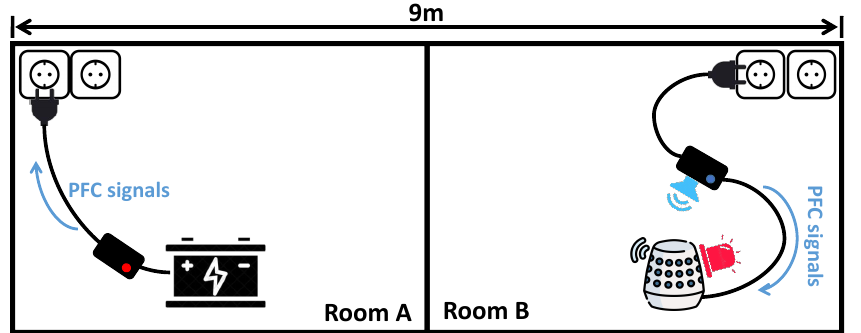
Figure 1. Diagram of signal propagation process. PFC signal generated by charger travels along grid and affects power supply to smart speaker, causing it to emit